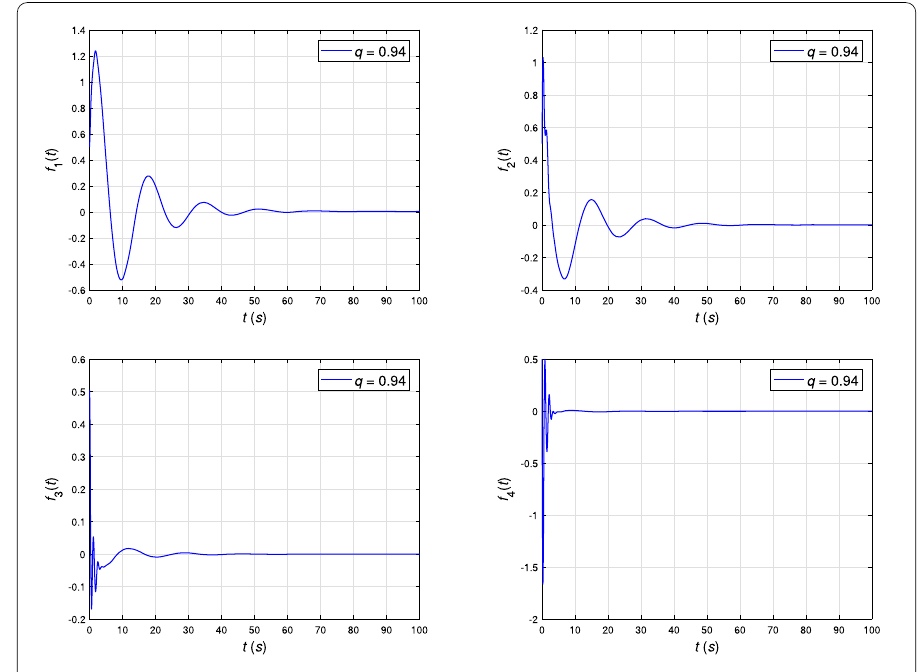
Figure 9 The time-domain responses of the controlled system (14) for q = 0.94